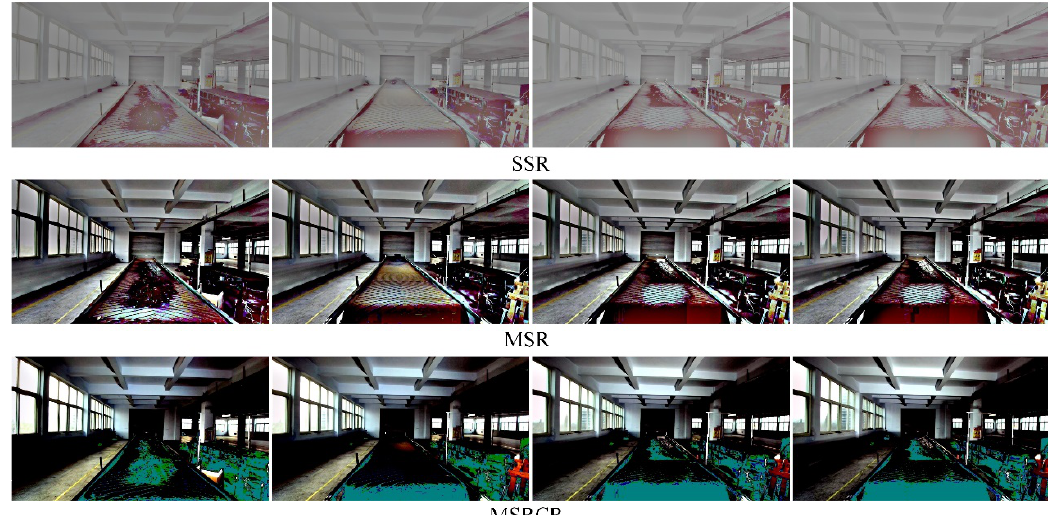
Figure 17. Enhancement of images with light sources in the evening by traditional algorithms.